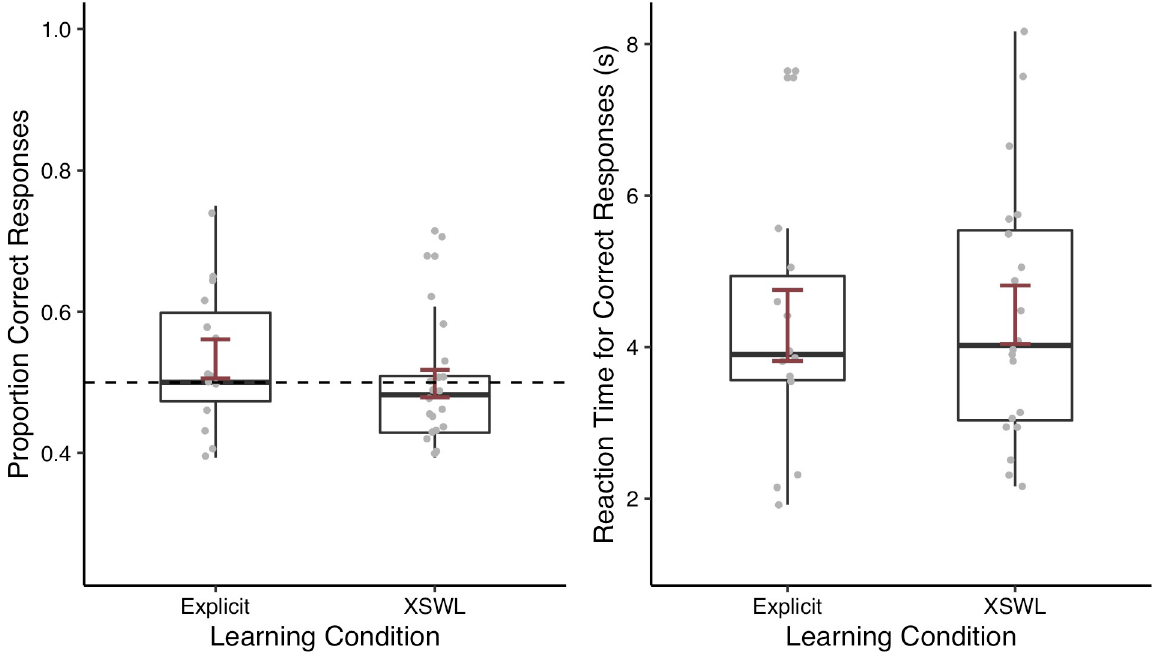
Fig 3. Proportion of correct responses (left) and reaction time (right) by participants who received training in the explicit learning condition or the ambiguous XSWL paradigm. Error bars represent one standard